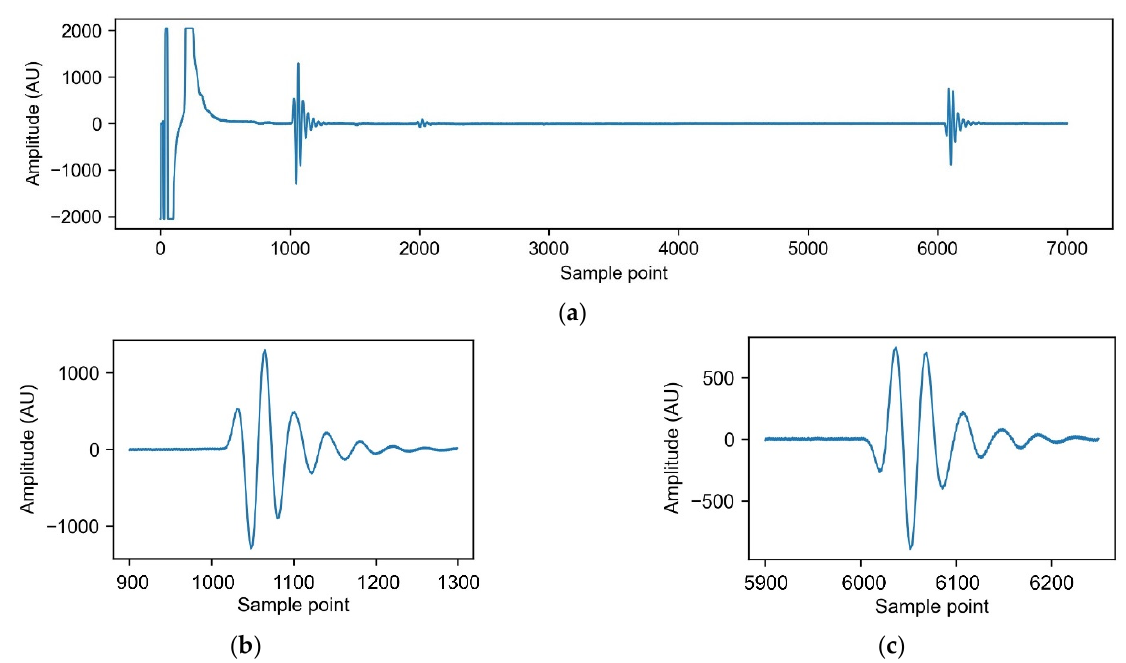
Figure 2. Example ultrasonic waveform obtained: ( a ) The 1st reflection is located around sample point 1000, the 2nd reflection is located around sample point 6000; ( b ) a close-up of the 1st reflection; ( c ) a close-up of the 2nd reflection.